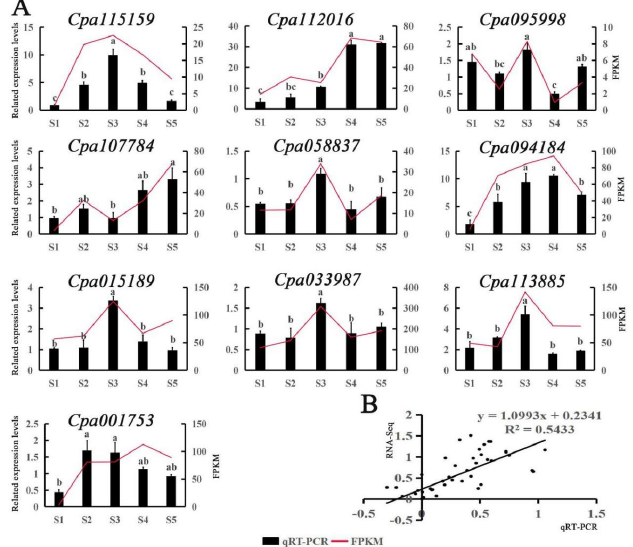
Figure 6. qRT-PCR validation of the transcriptome data results for 10 selected genes. S1–S5 represent CK, Salt, Salt + SNP, Salt + NaHS, and Salt + MeJA treatments, respectively. ( A ) Expression levels of 10 genes and FPKM values. The red folds represent FPKM values in transcriptome data, and the vertical bars shown in the columns represent relative expression level by qRT-PCR. Different letters denote significant differences according to Tukey’s test ( p < 0.05). ( B ) Correlation analysis of the gene expression ratios between qRT-PCR and FPKM.